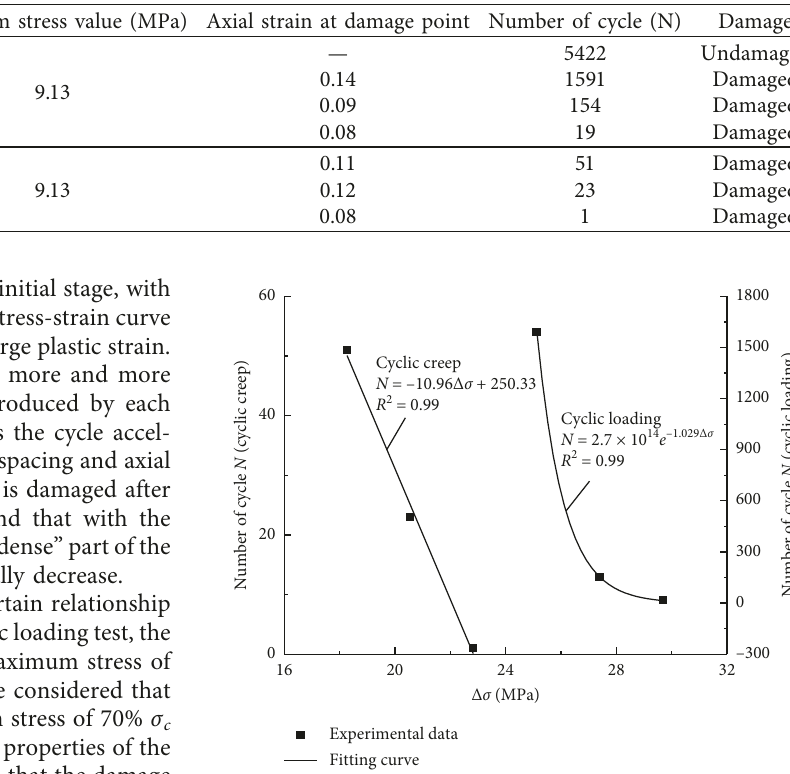
Table 2: Results of cyclic loading and cyclic creep tests on rock salt.